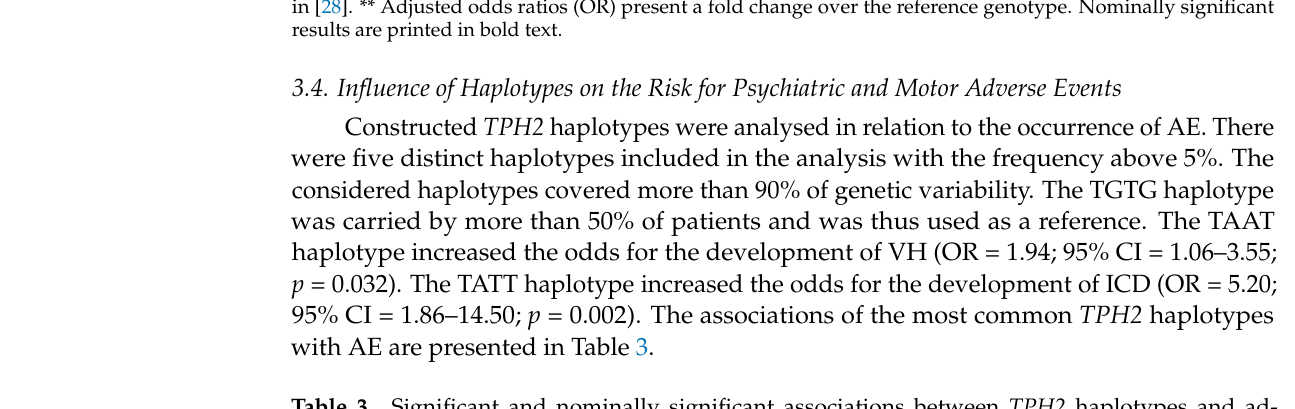
Table 3. Significant and nominally significant associations between TPH2 haplotypes and ad- verse